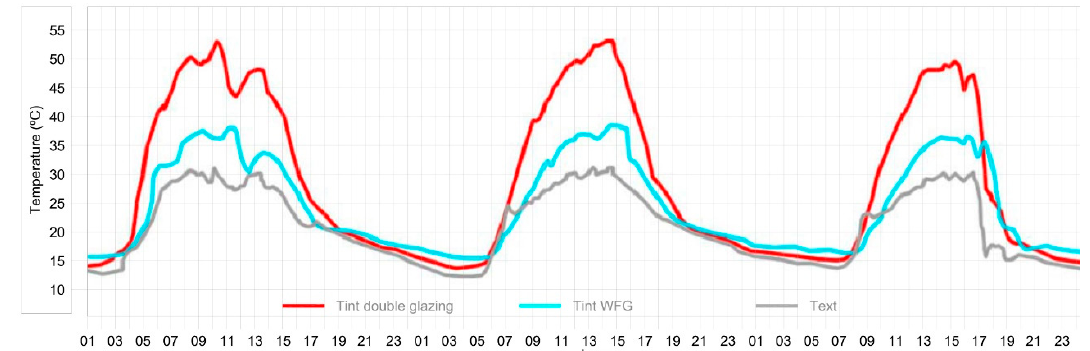
Figure 5. Measured data of the outdoor temperature and the indoor temperature of the WFG cabin Reference cabin. Sample summer days: 23 / 08 / 2010, 24 / 08 / 2010, and 25 / 08 / 2010. and Reference cabin. Sample summer days: 23/08/2010, 24/08/2010, and 25/08/2010.